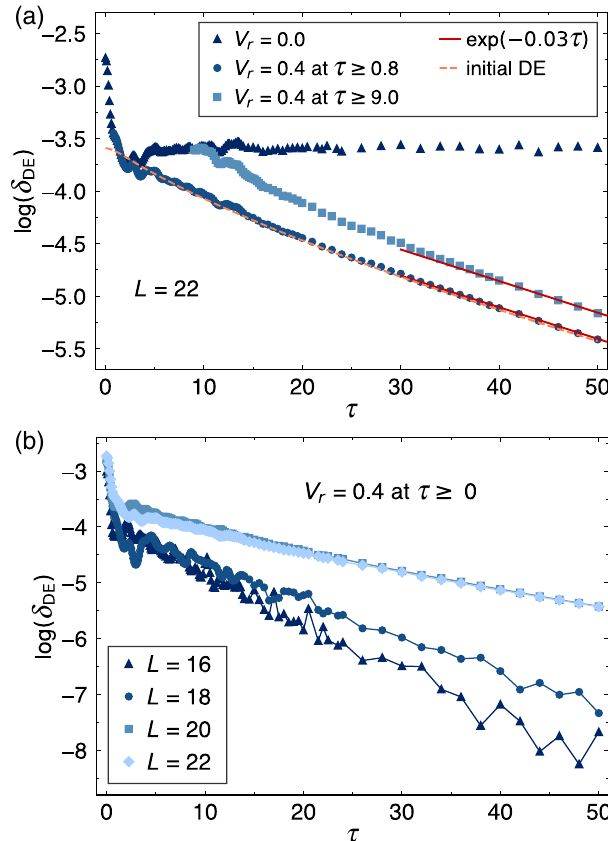
τ Þ [see Eq. (L4)] versus τ for FIG. 17. (a) RMS distance δ τ Þ [defined in Eq. (9)] versus τ FIG. 18. (a) RMS distance δ GE ð DE ð quenches in which V ¼ 1 . 6 and the integrability breaking V 0 . 4 , and L ¼ 22 . for two-step quenches in which V ¼ 1 . 6 , V r r ¼ takes different values. The results shown are for a system with The distance is computed, in all cases, from the DE result for the τ Þ versus τ for quenches in L ¼ 22 sites. (b) RMS distance δ single quench. Results are shown when the second quench is GE ð 0 . 4 , and for different lattice sizes ( L ¼ 16 , which V ¼ 1 . 6 , V carried out at τ ¼ 0 . 8 and 9.0 following the first quench, and at r ¼ 18, 20, and 22). Inset in (b): Distance between the diagonal and τ ¼ 0 when starting with the DE of the integrable system after the the grand canonical ensembles δ ð DE-GE Þ [see Eq. (L5)] versus L first quench (labeled as “ initial DE ” ). The solid lines at long times 0 . 4 (as in the main panel). The black for V ¼ 1 . 6 and V r ¼ depict exponential behavior indicating the same relaxation rate in dashed line depicts exponential behavior. all cases. (b) Distance to equilibration in single quenches for different systems sizes L . These results show the finite-size effect on the relaxation